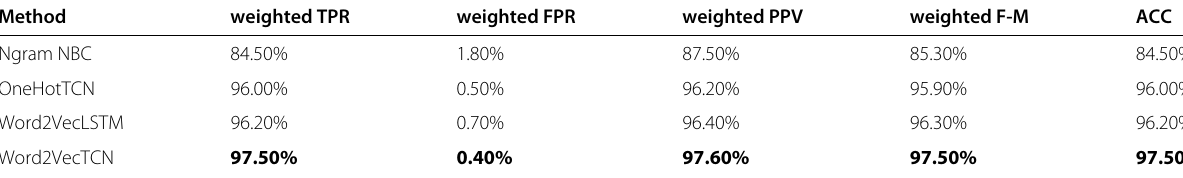
Table 3 Performance comparisons of malware categorization